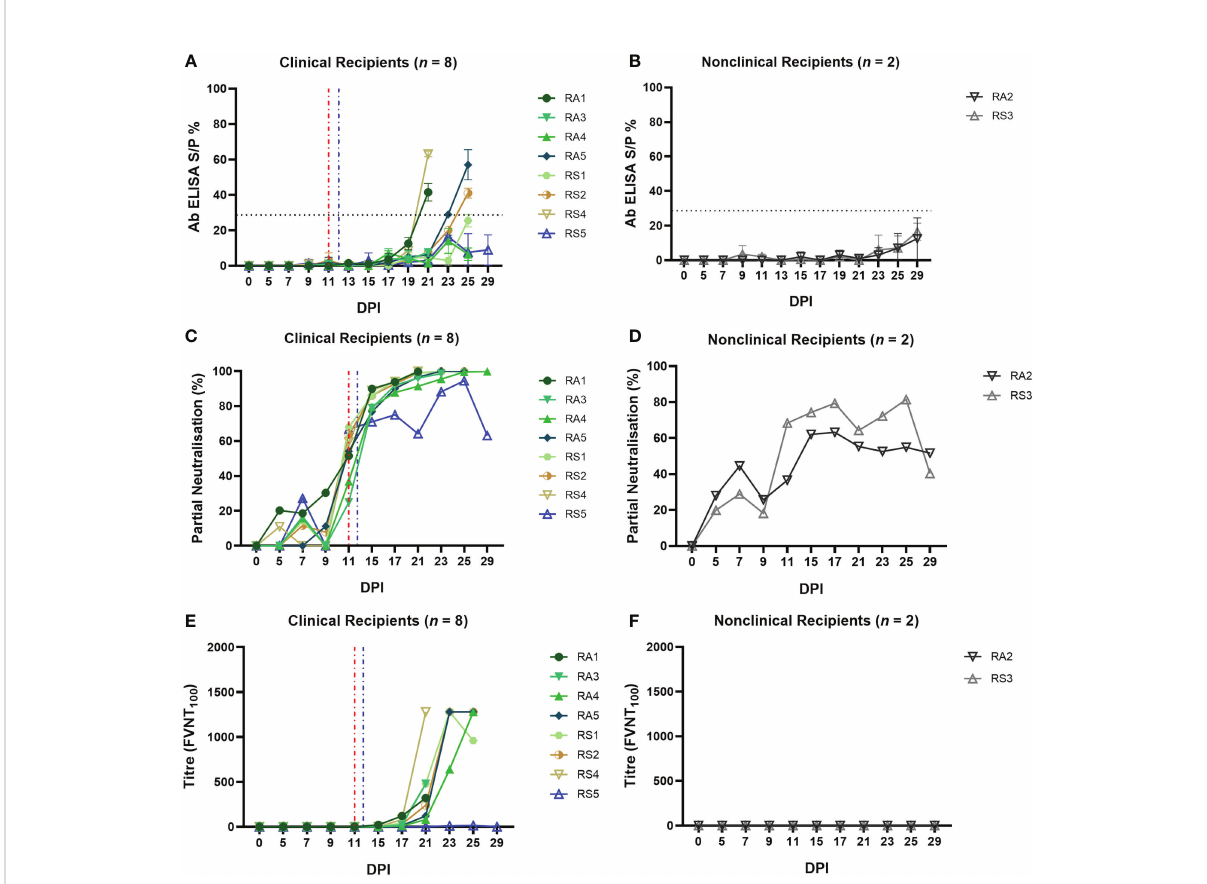
FIGURE 8 Calves that develop clinical disease following arthropod inoculation with LSDV develop a rapid and robust humoral immune response as measured either by ELISA or FVNT. The antibody responses in calves after needle – inoculation with LSDV was measured using the ID Screen ® Capripox Double Antigen Multi – species ELISA kit (Innovative Diagnostics) following manufacturer instructions (A, B) . The error bars represent the SEM. The production of neutralising antibodies was measured using a fl uorescent virus neutralisation test. The percentage of viral foci – forming units neutralised by the sera was measured over time in clinical (C) and nonclinical (D) calves. Complete neutralisation of the virus (FVNT 100 ) was also calculated in clinical (E) and nonclinical (F) calves. Red dotted line represents the onset of lesions for group RS cattle and the blue dotted line for group RA